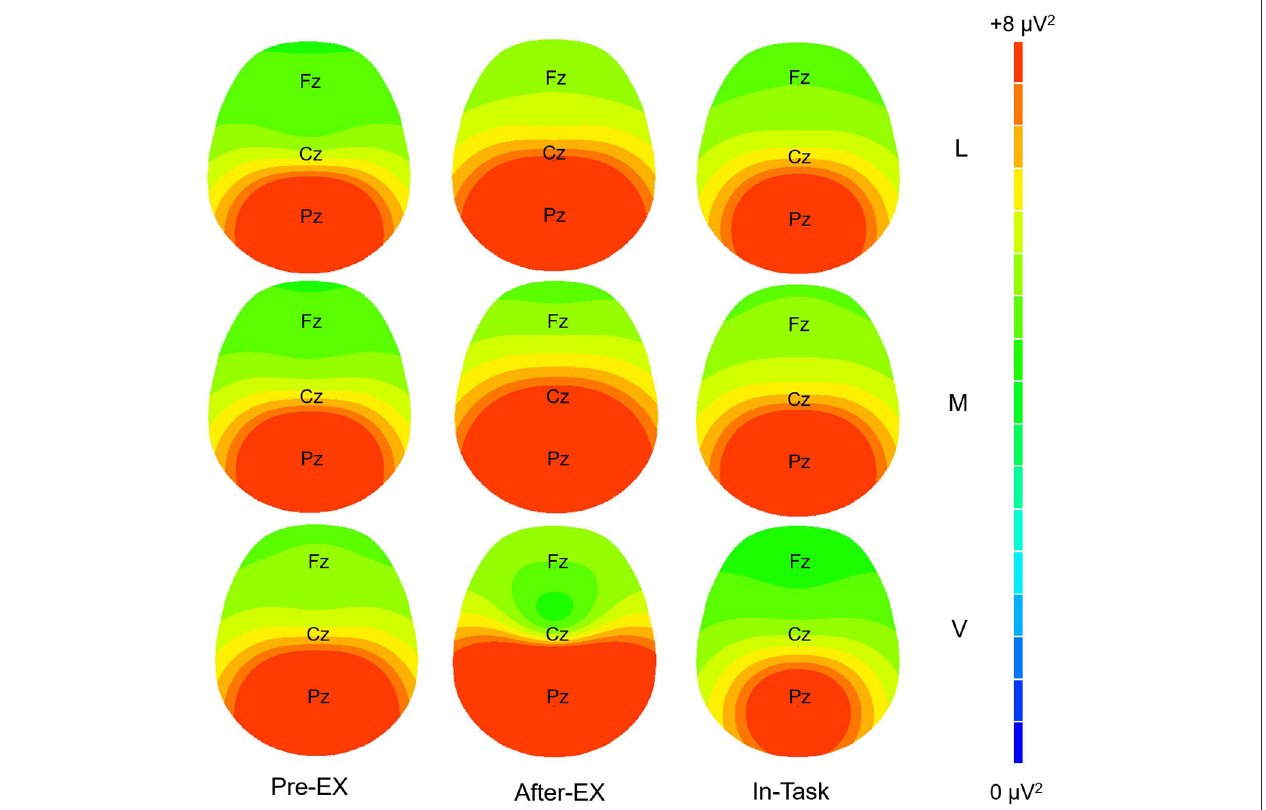
FIGURE 3 | Topographic distribution of alpha power. The topographic distribution of alpha power (spectrum: blue to red) is illustrated for three intensity exercises and time, respectively. L, low-intensity exercise; M, moderate-intensity exercise; V, vigorous-intensity exercise.